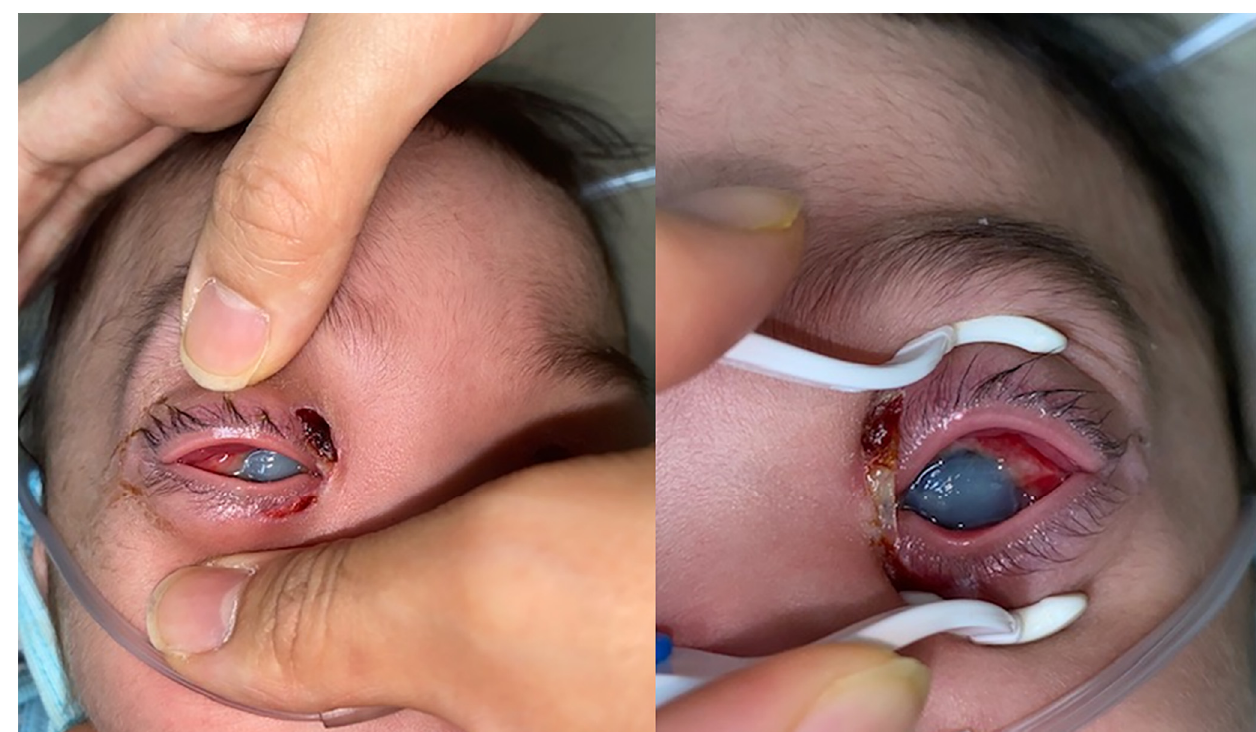
Figure 1. Anterior photography showing chemosis, corneal opacity, and corneal ulcer.